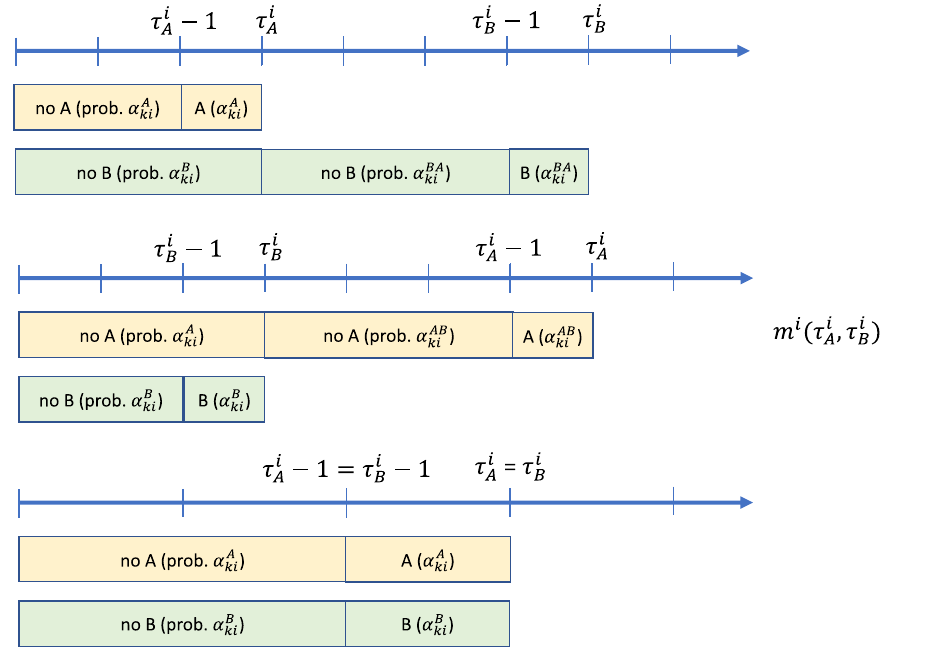
FIG. 9. Three cases to consider for the marginals and messages for the time trajectory ð τ A i ; τ B i Þ